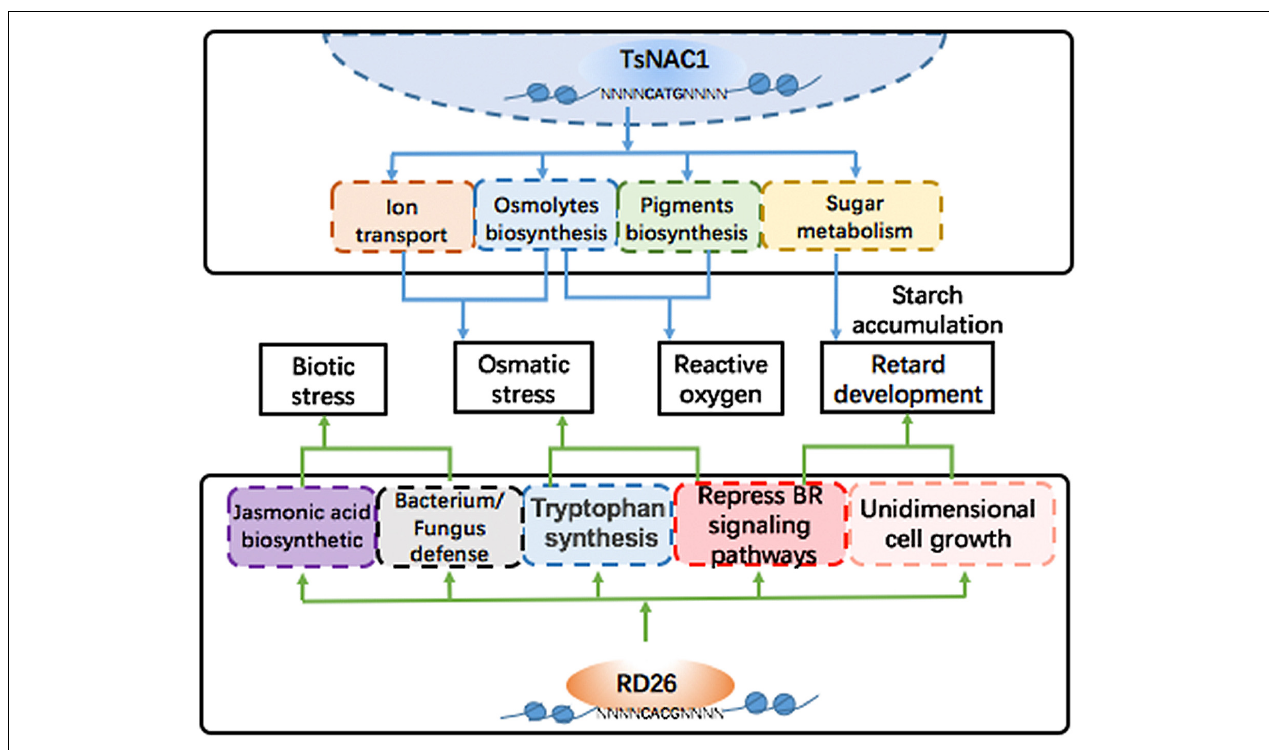
FIGURE 7 | Regulated networks of EsNAC1 and RD26. EsNAC1 improved the osmotic stress and the reactive oxygen stress tolerance of plants via regulating the transport of ions and the biosynthesis of pigments and osmolytes and retarded the development of plants via regulating the sugar metabolism and the accumulation of starch. By contrast, the overexpression of RD26 retarded plant development via repressing genes of the BR signaling pathways and unidimensional cell growth. Additionally, RD26 could regulate the biosynthesis of jasmonic acid to improve biotic stress tolerance but showed no genes for reactive oxygen stress